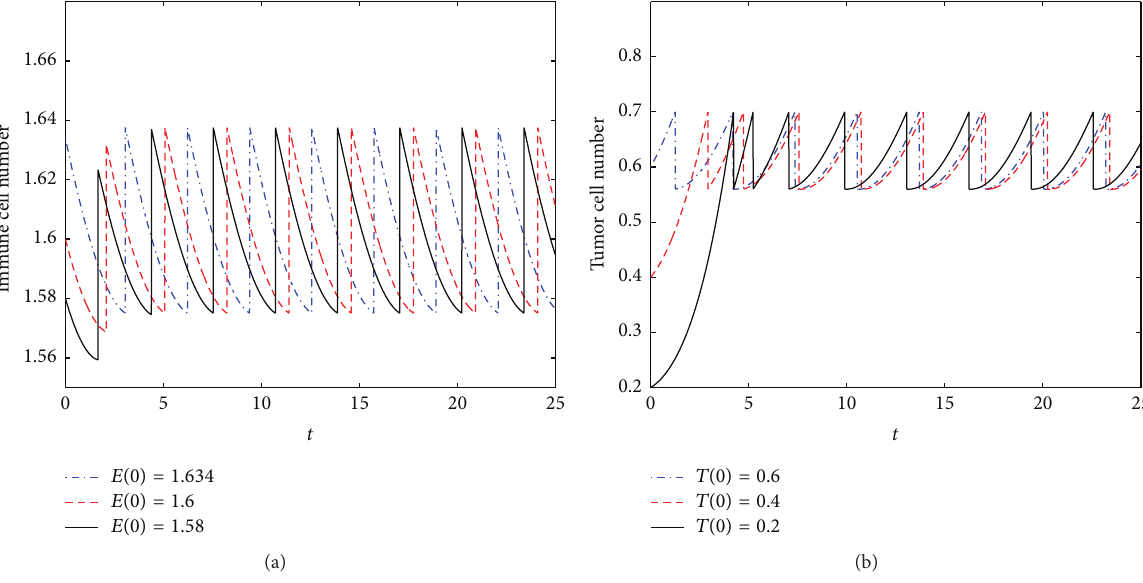
Figure 3: The existence and stability of positive order-1 periodic solution of model (4) for case (iii) in Lemma